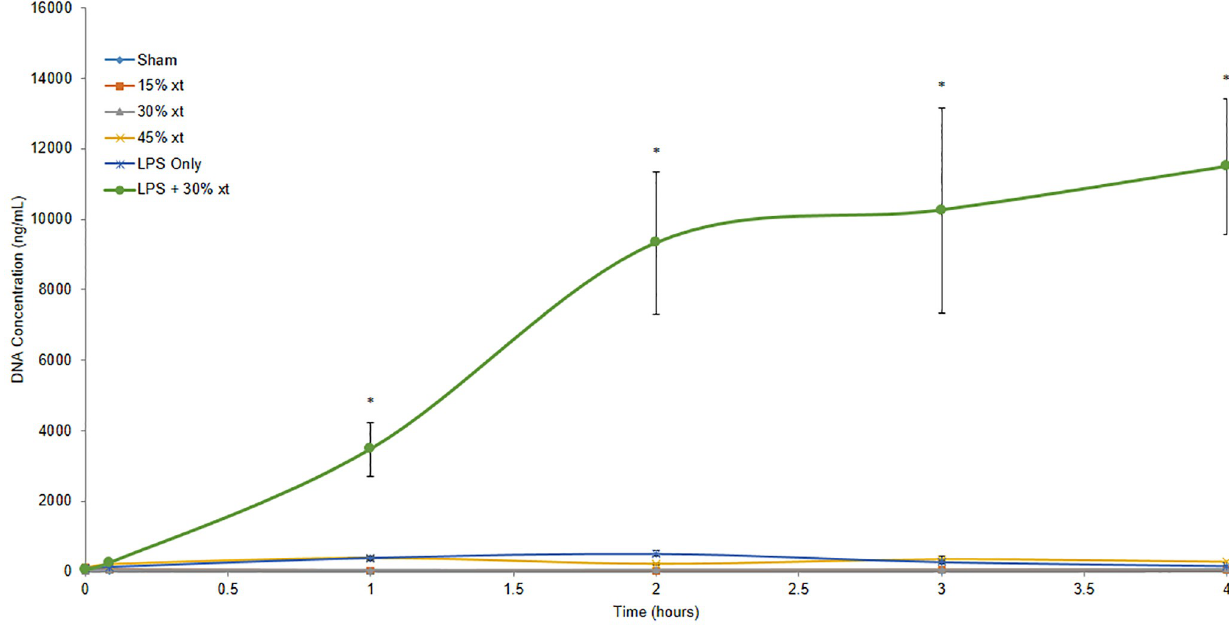
Fig 8. LPS+30% transfusion increases the level of free DNA in circulation. Plasma was isolated from animals prior to receiving LPS alone (n = 3), 15% (n = 3), 30% (n = 3), 45% (n = 3) erythrocyte transfusion (xt) alone or LPS+30% erythrocyte transfusion (n = 3) and then at 5, 60, 120, 180 and 240 minutes after transfusion. Plasma samples were incubated with PicoGreen. Fluorescence was read at an excitation wavelength of 485 nm and an emission wavelength of 520nm in a microplate reader. All free DNA measurements for each animal were done in triplicate. Data are means and standard error of the mean. Statistical analysis was performed using an ANOVA followed by Student t -test. � denotes P < 0.001 compared to all other experimental groups at the corresponding timepoint.